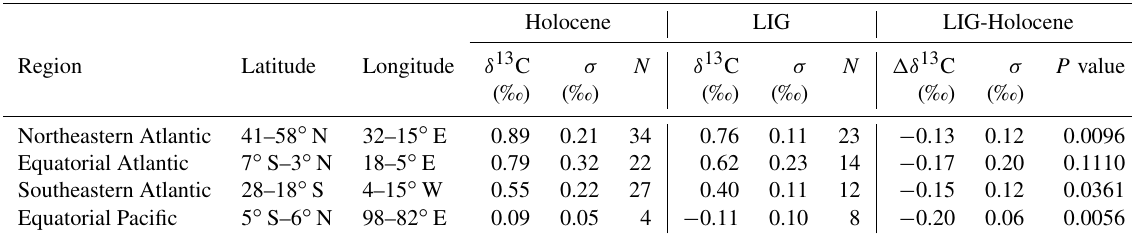
Table 3. Regional summary of δ 13 C below 2500m depth for the LIG (125–120kaBP) and Holocene (7–2kaBP) using a single value per core for each time slice. Shown are the non-volume-weighted means ( δ 13 C, ‰), standard deviations ( σ , ‰), and counts ( N ) for both time periods, along with the time period regional anomalies ( (cid:49)δ 13 C, ‰), propagated standard deviations for the anomaly ( σ , ‰), and p values from two-sample t tests between the two time